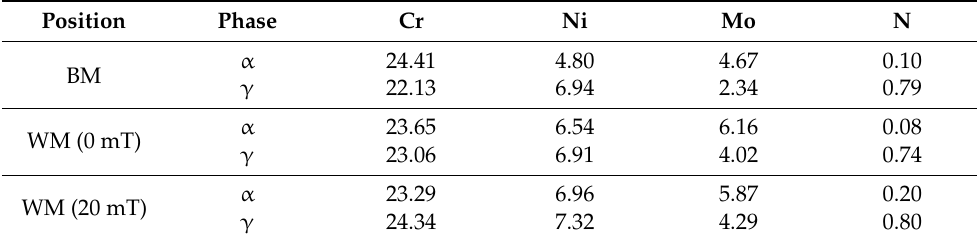
Table 3. Mass percentage (%) of each element in austenite and ferrite in different areas of welded joints.